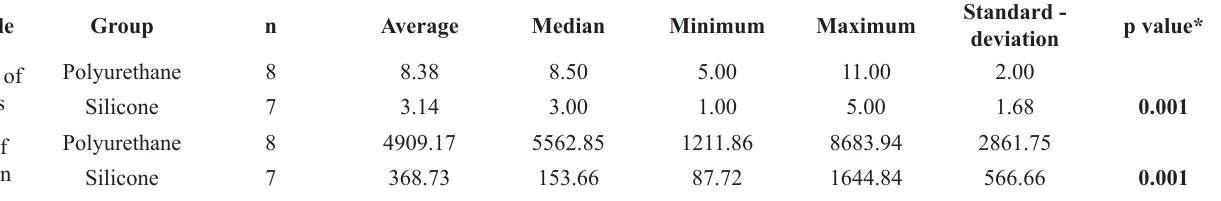
TABLE 5 - Moment of 28 days with number of vessels and area of collagen.